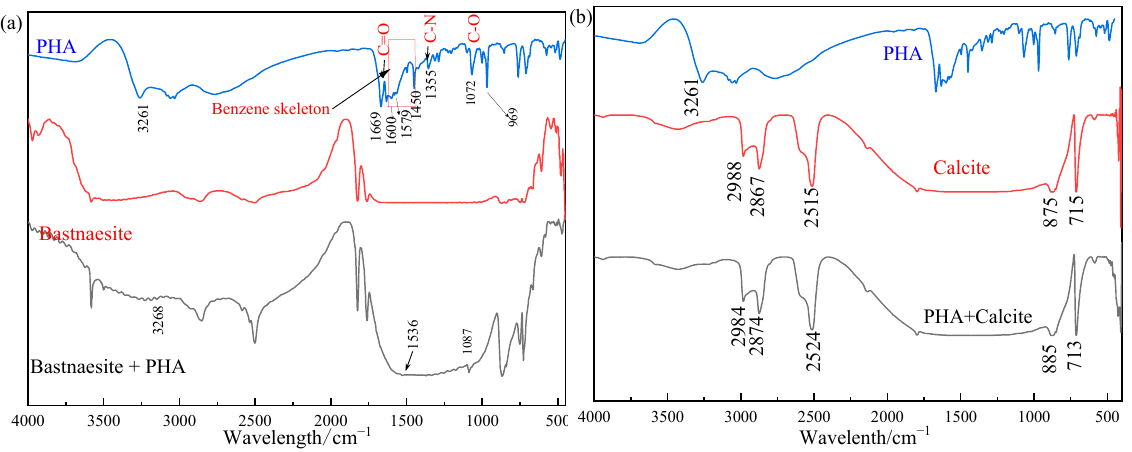
Figure 7. Infrared spectrum results of bastnaesite ( a ) and calcite ( b ).